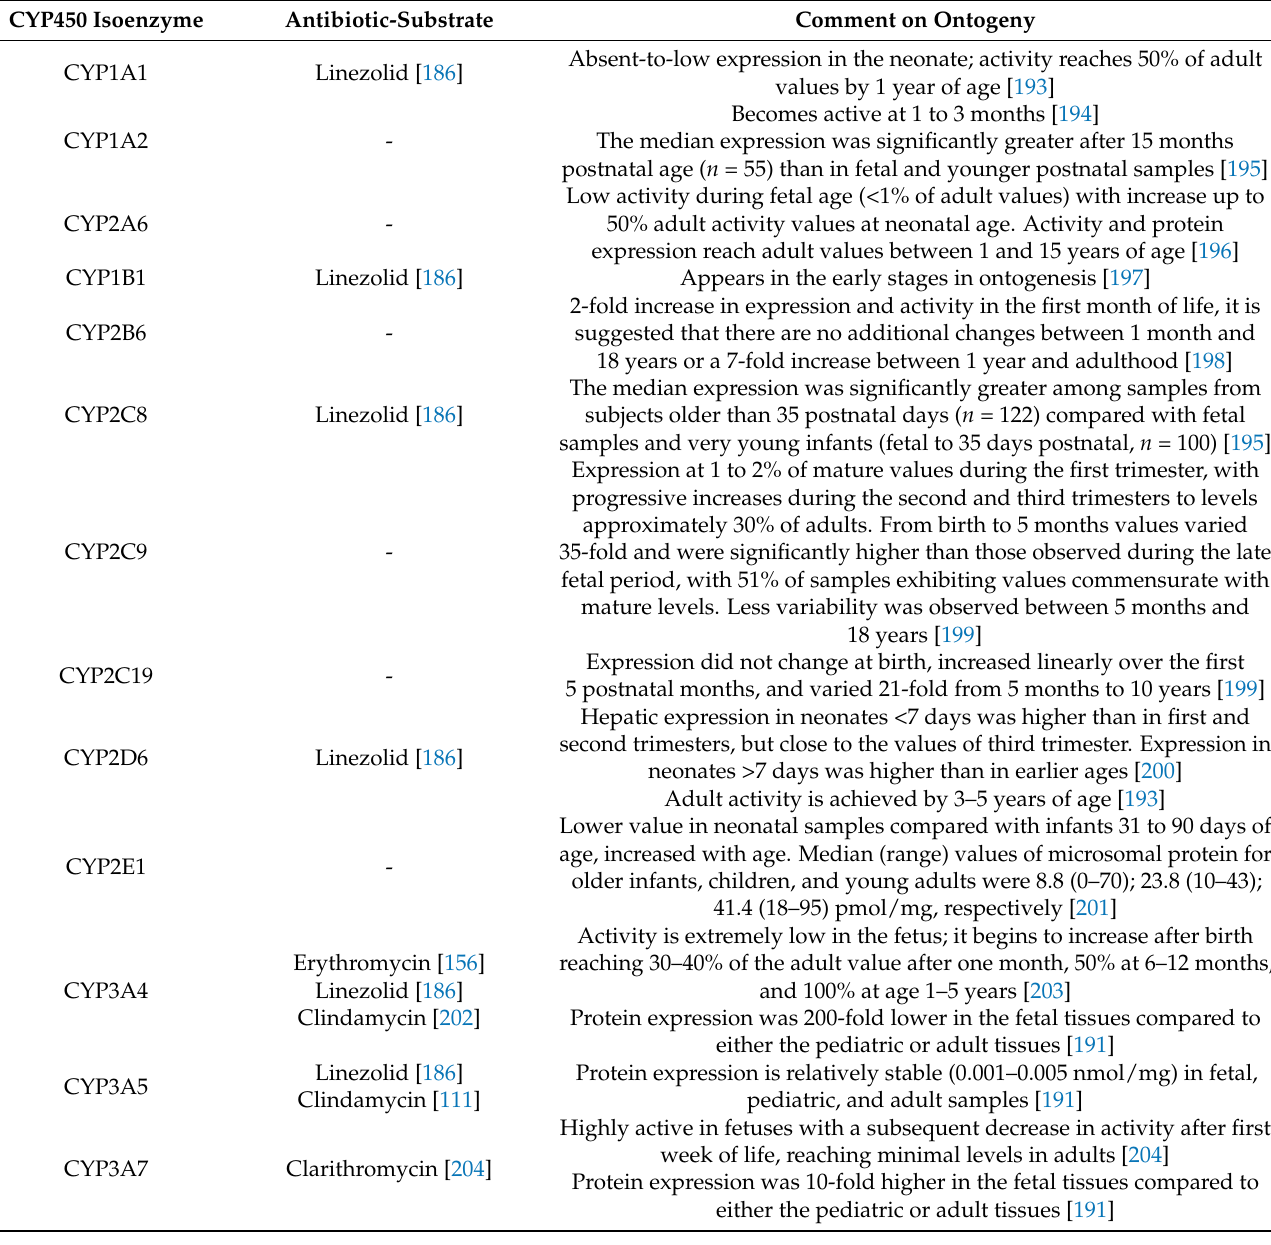
Table 7. CYP450 isoenzymes ontogeny and